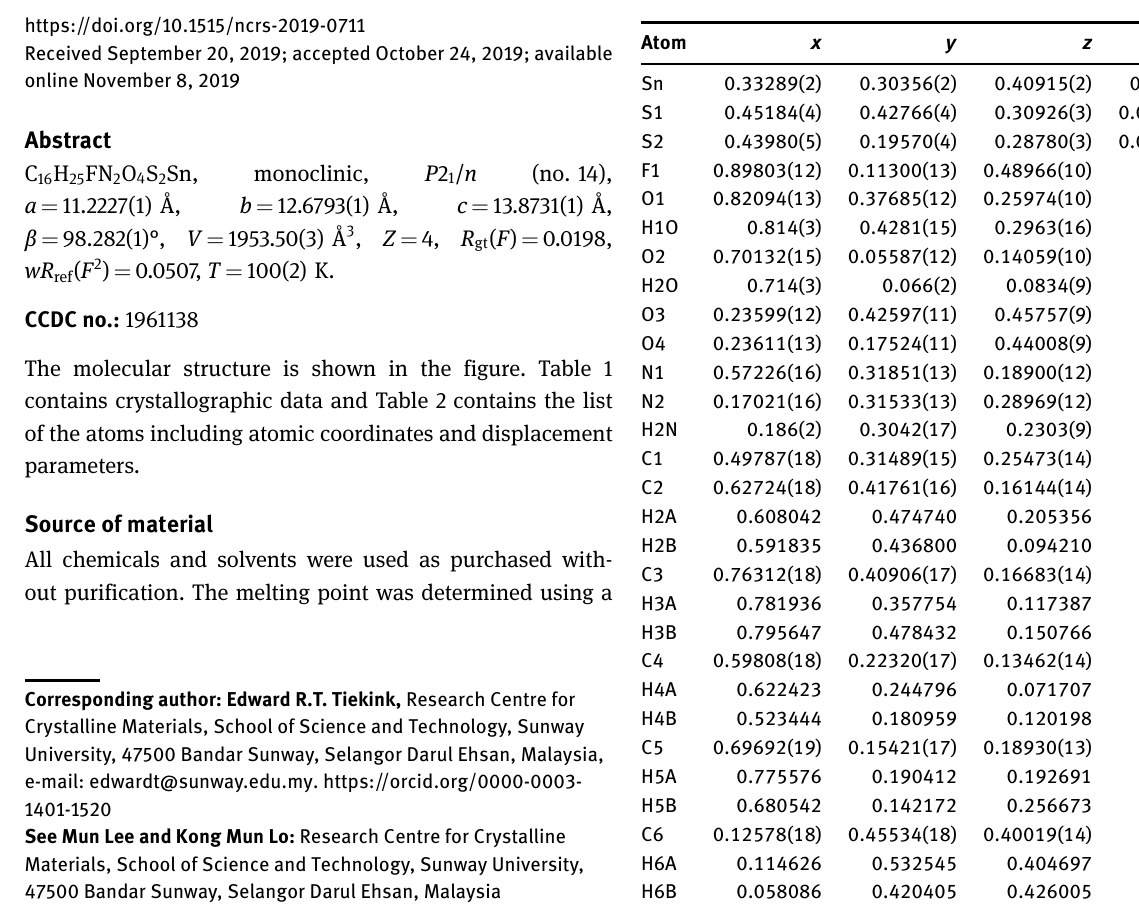
Table 2: Fractional atomic coordinates and isotropic or equivalent isotropic displacement parameters (Å 2